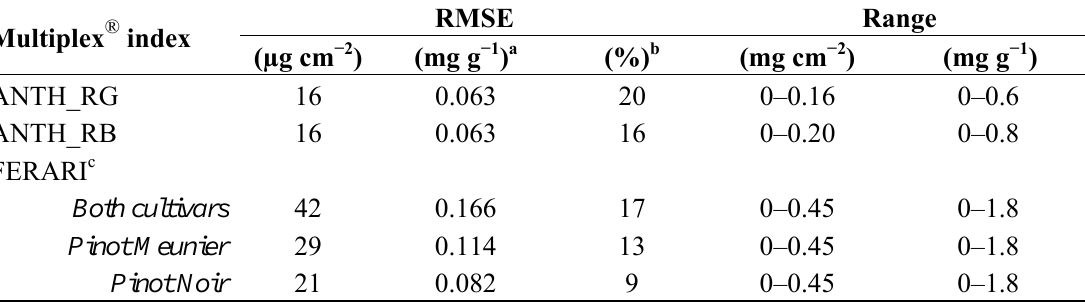
Table 3. Range of applicability and precision of Multiplex ® indices for the estimation of anthocyanins using only the rising part of the response curve for Multiplex ®